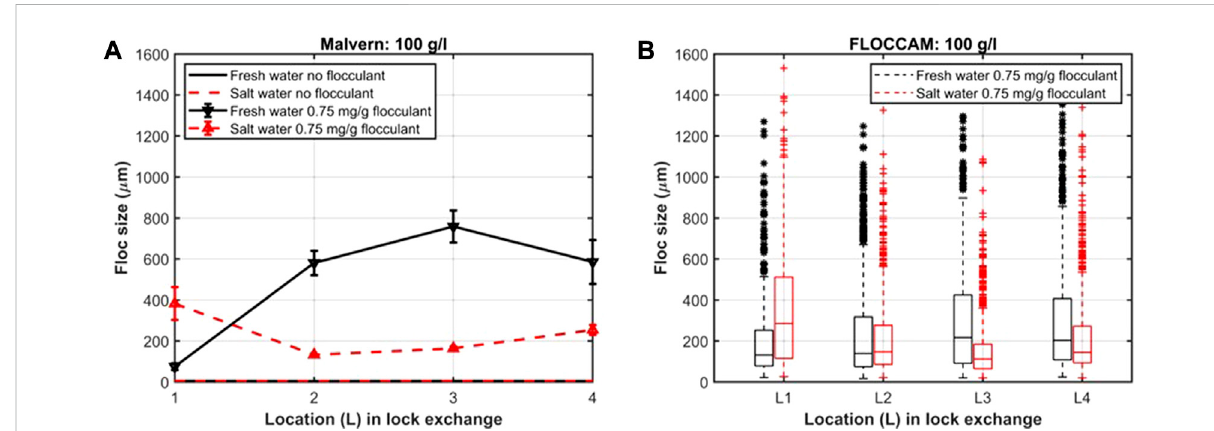
FIGURE 6 Hydrodynamic diameter of illite fl ocs for 100 g L − 1 experiments at L1-L4 locations of the lock exchange. Figure (A) , results obtained by SLS and fi gure (B) , results obtained from FLOCCAM. Black and red lines represent experiments done in freshwater and saltwater, respectively. Only results with 0.75 mg g − 1 of fl occulant are shown.